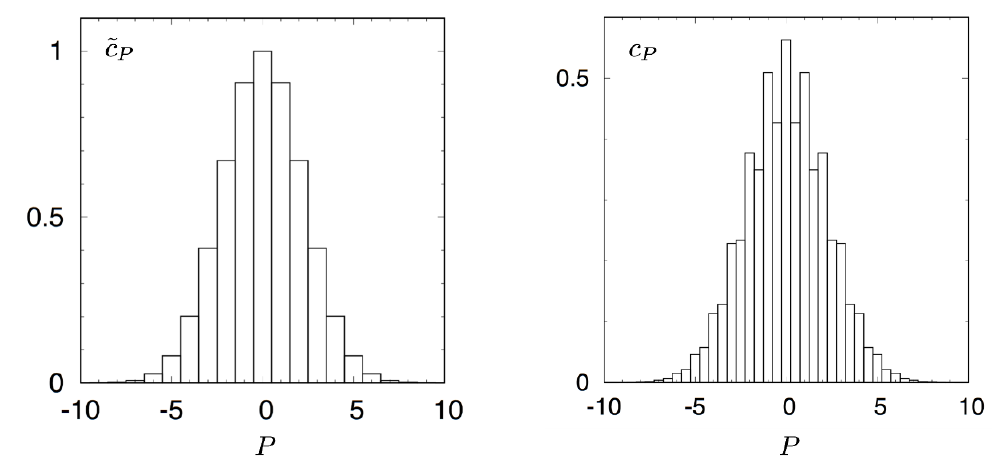
Figure 1 . An example of the relation between ~ c P (left) and c P (right) for N =